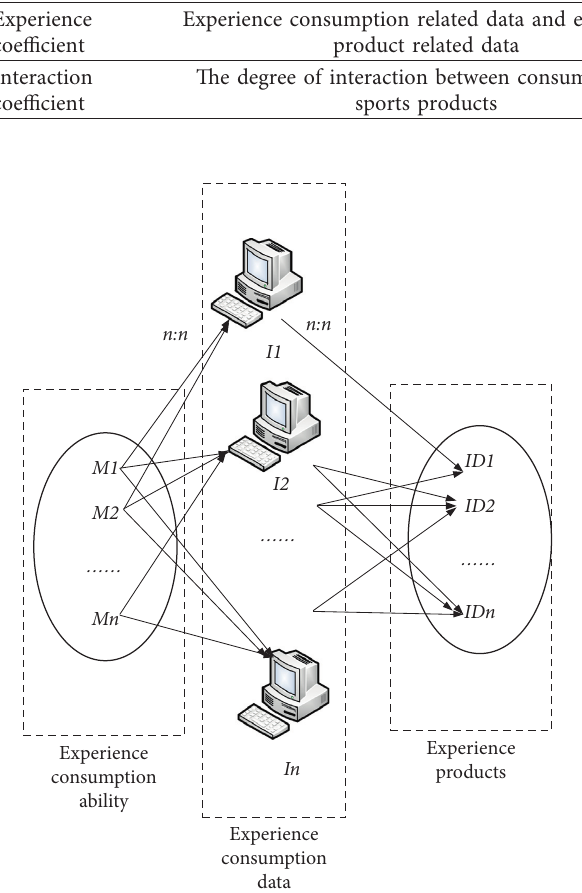
Figure 1: The relationship among experience consumption ability index, experience data, and sports